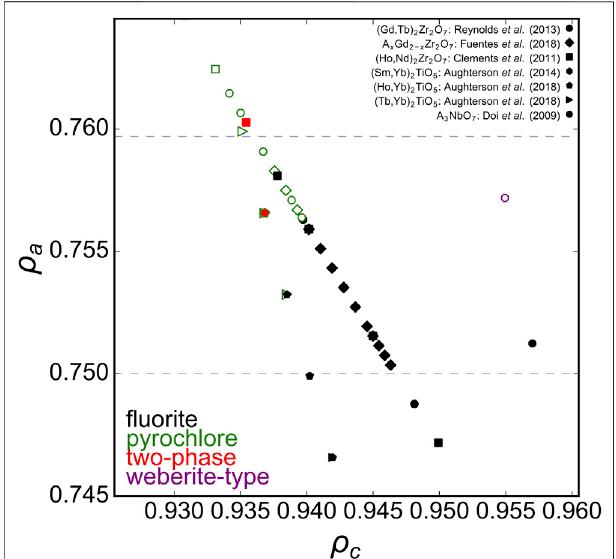
FIGURE 3 | Ternary A 2 B 2 O 7 solid solution series in the ρ a , ρ c phase space with ρ c boundaries (red dashed vertical lines) established from A 2 Hf 2 O 7 compositions ( Figure 2 ). Experimental data taken from Heremans et al. (1995),Kennedyetal.(1997),Wuenschetal.(2000),Glerupetal.(2001), Norbergetal.(2012),DeLosReyesetal.(2013),Zhangetal.(2013),Sha fi que et al.(2016),Tracyetal.(2016),and Dreyet al.(2020) withreportedstructures that correspond to disordered fl uorite (solid black squares), ordered pyrochlore(opengreencircles),andamixofboth(reddiamonds).Thedashed graylinesconnectthedatapointsandrepresentthetrendofthesolid-solution series within this phase space.